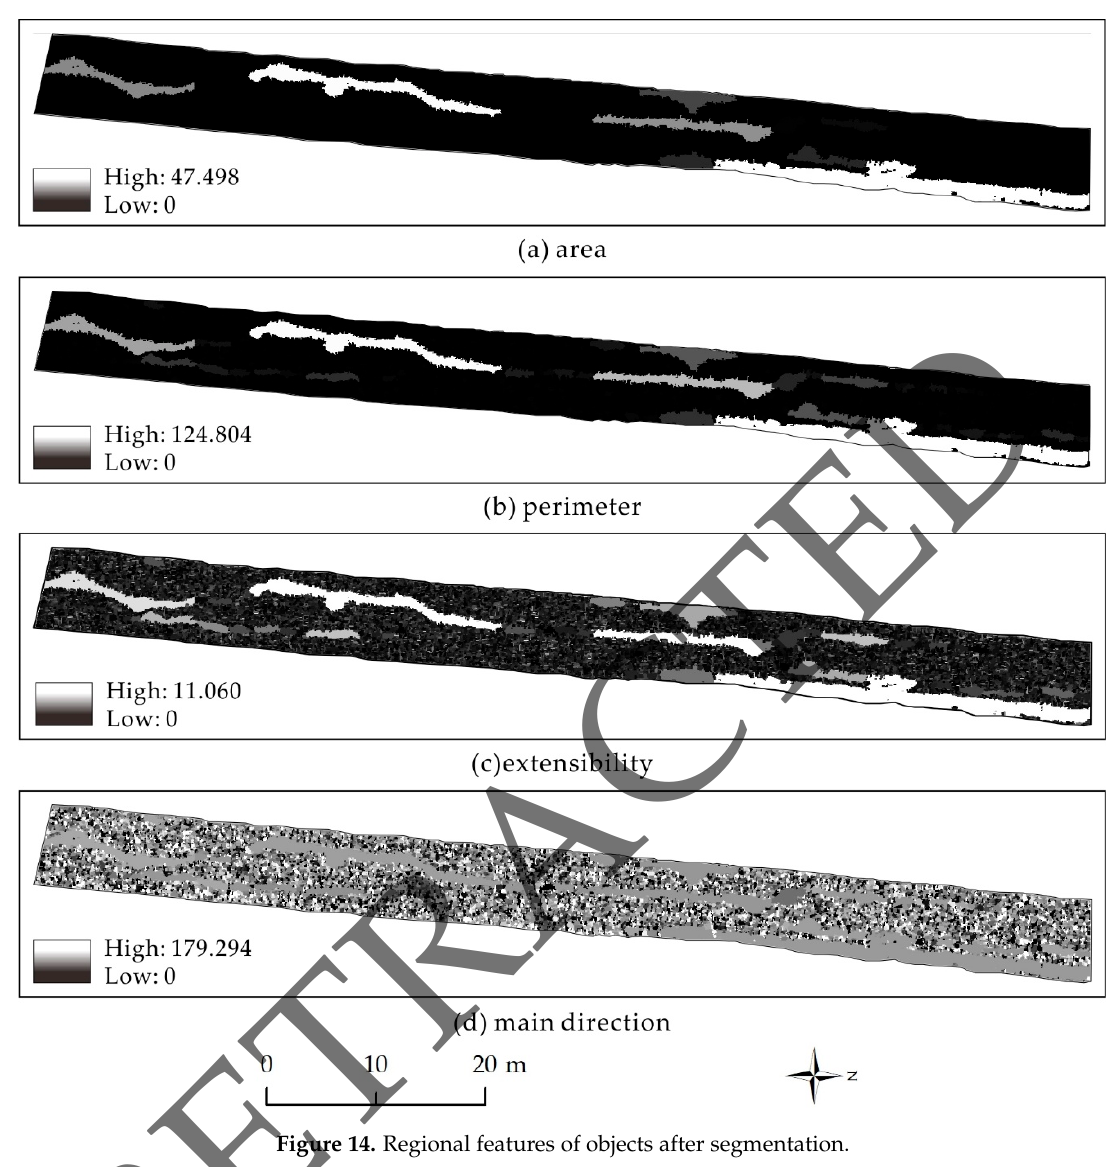
Figure 14. Regional features of objects after segmentation.